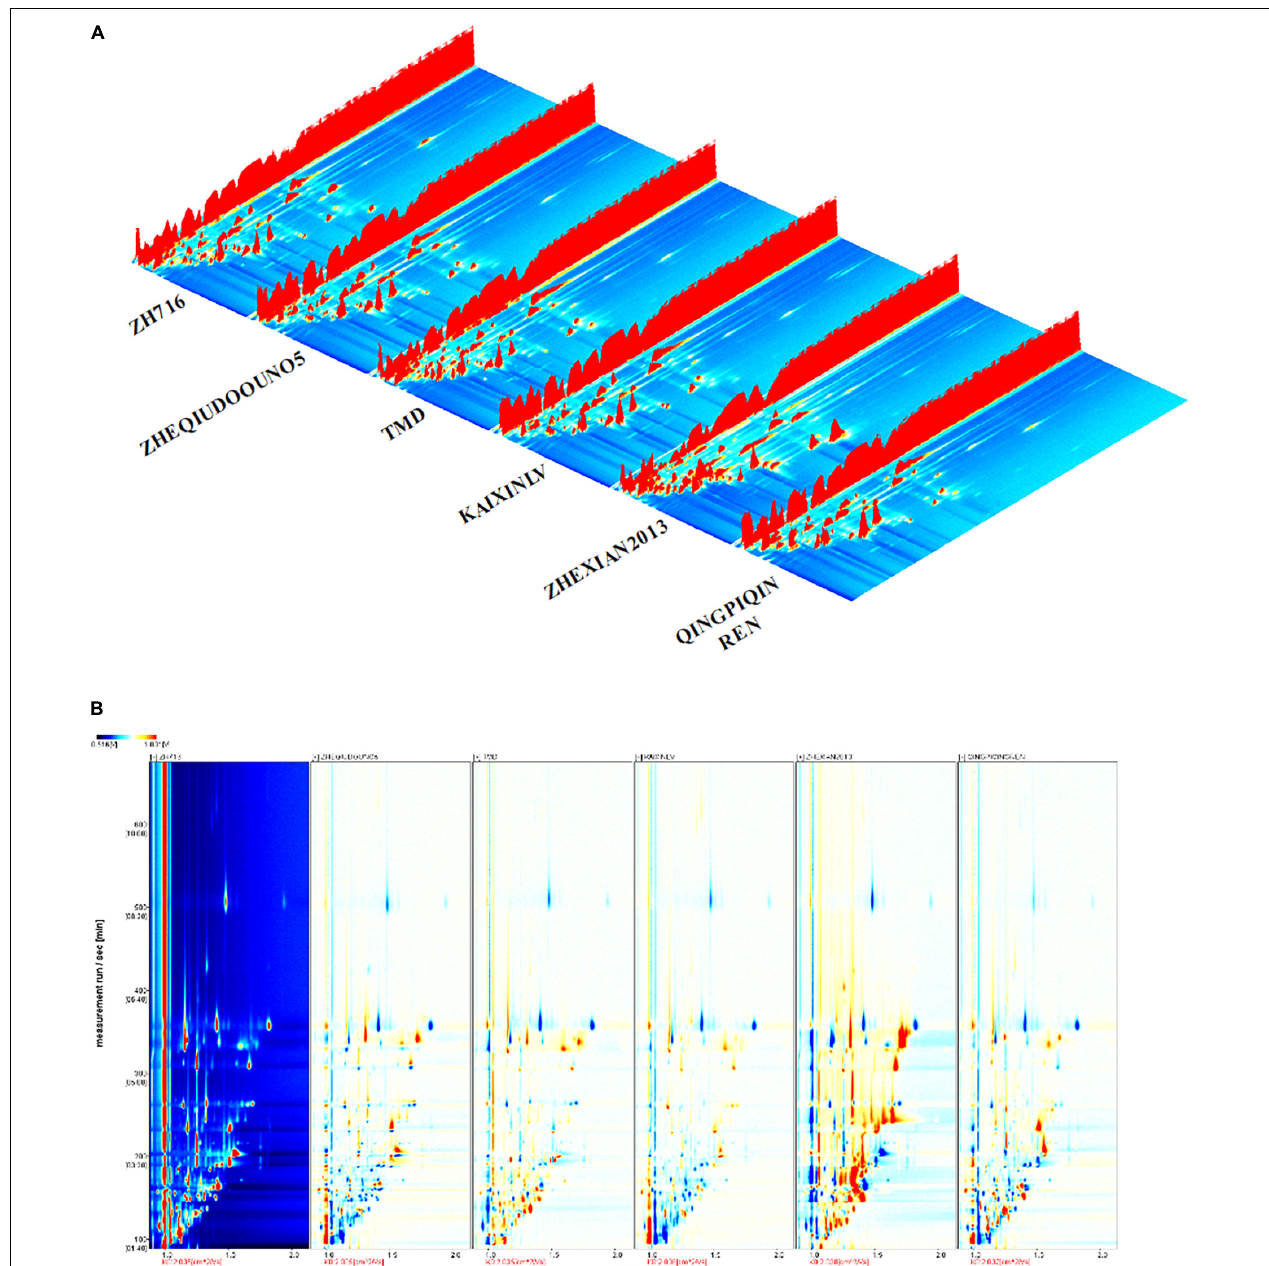
FIGURE 1 | Changes in the volatile compounds from the seeds of six representative vegetable soybean cultivars shown in three-dimensional (3D) (A) and two-dimensional (2D) (B) topographic